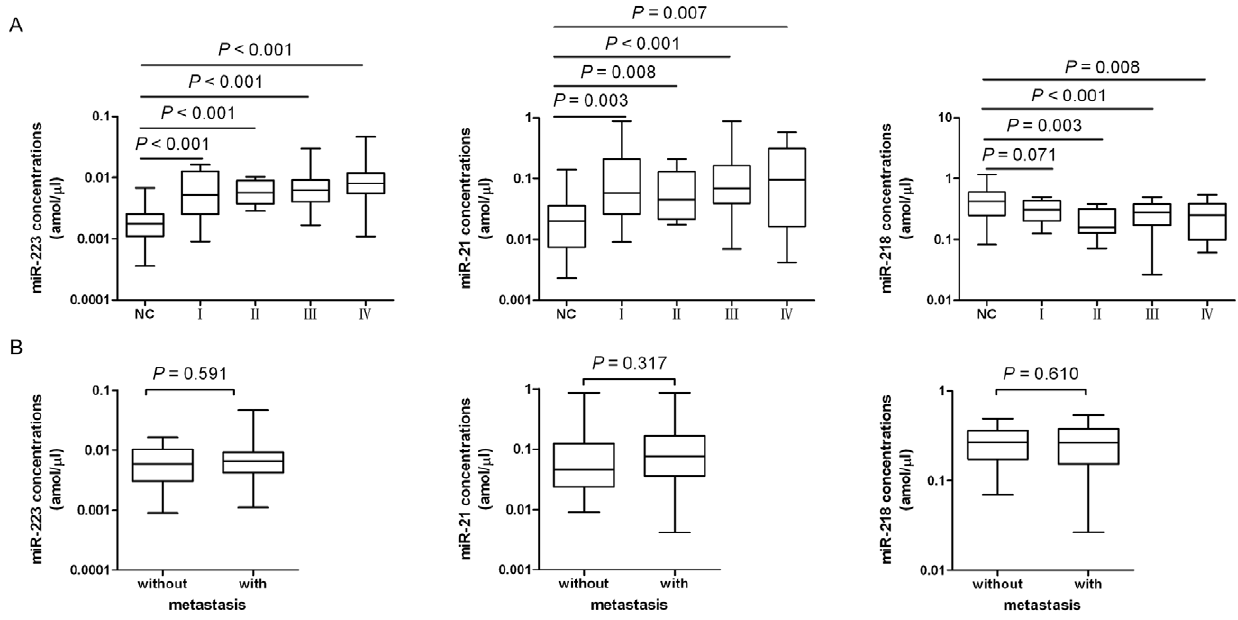
Figure 4. Evaluation of the plasma concentrations of miR-223, miR-21 and miR-218 in GC patients at different clinical status. (A) Box plots of the plasma concentrations of miR-223 (left panel), miR-21 (middle panel) and miR-218 (right panel) in healthy controls (NC, n=70) and gastric cancer (GC, n=70) patients at different TNM stages (12 with I, 11 with II, 36 with III and 11 with IV). (B) Box plots of the plasma concentrations of miR- 223 (left panel), miR-21 (middle panel) and miR-218 (right panel) in GC patients with or without metastasis. The lines inside the boxes denote the medians. The whiskers of box plots: Min to Max.